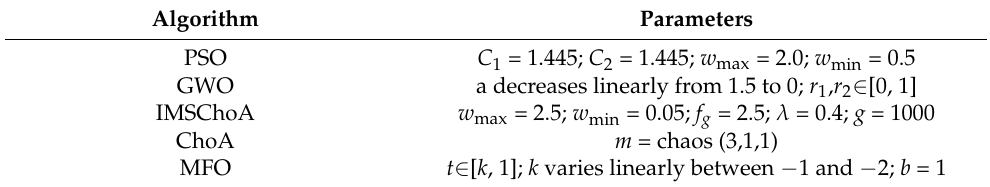
Table 1. Parameter table of the algorithm.